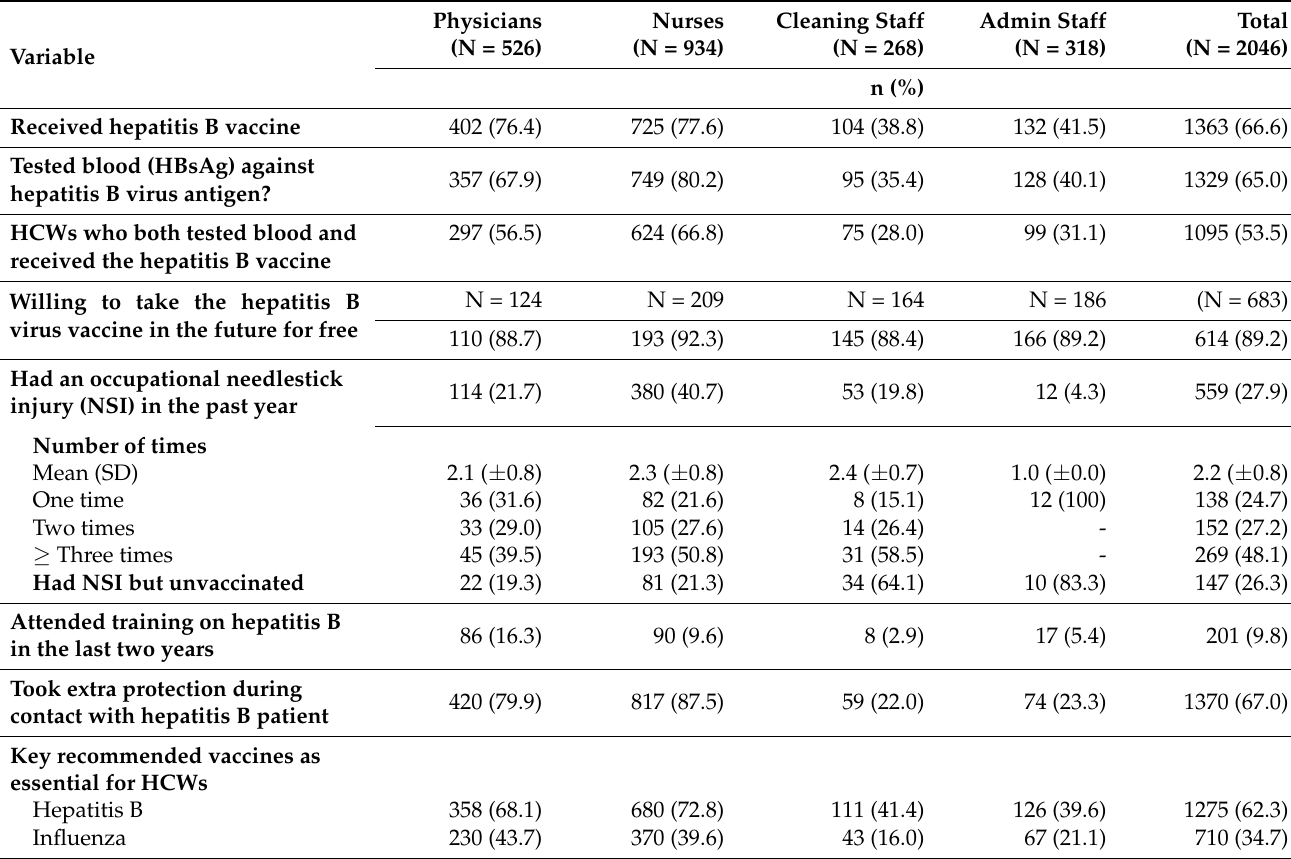
Table 2. Uptake of hepatitis B vaccination among participating